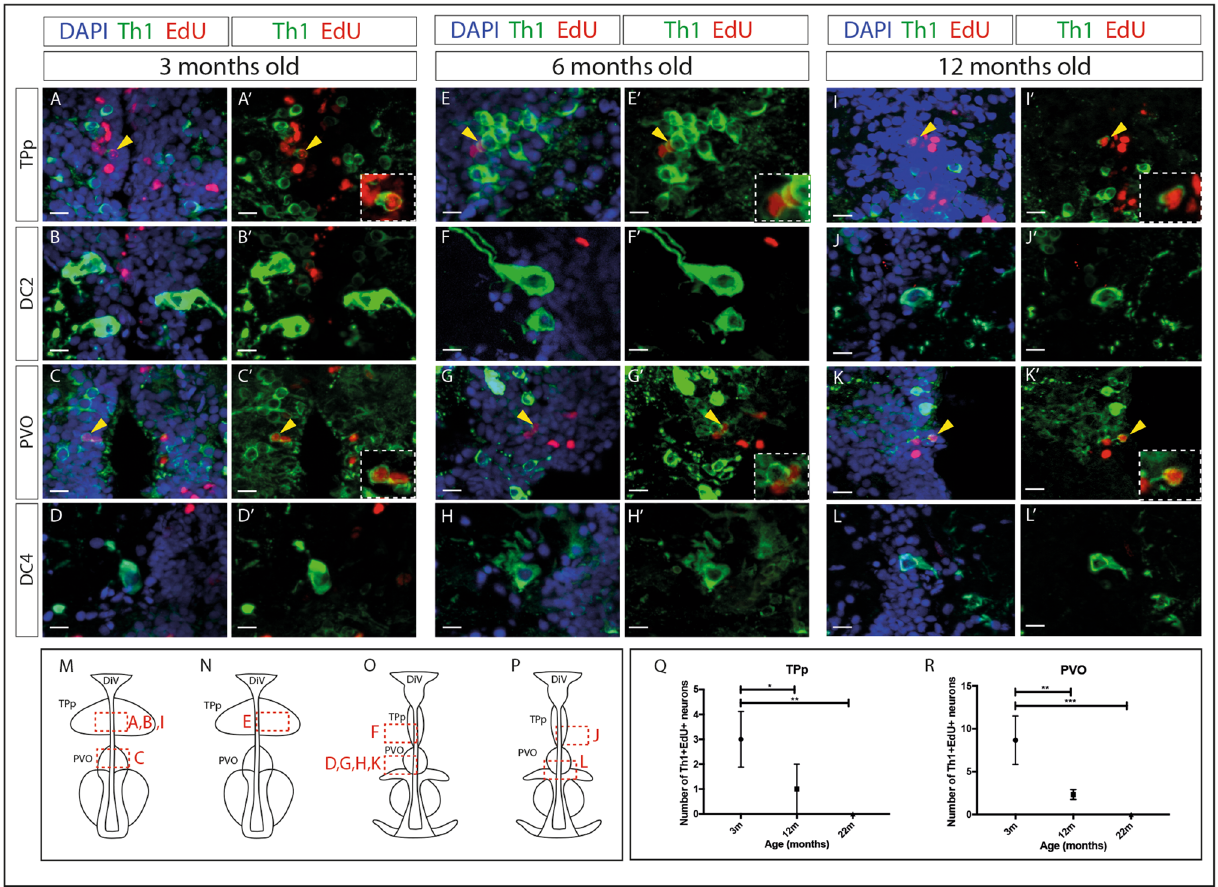
Figure 3. DA neurons are generated in the PT in adulthood, but generation decreases with age. ( A–L ′ ) Immunohistochemical analysis for Th1 (green), ClickIT™ labeling for EdU (red) and counterstained with DAPI (blue) ( A , B , C , D , E , F , G , H , I , J , K , L ) or shown without DAPI ( A ′ , B ′ , C ′ , D ′ , E ′ , F ′ , G ′ , H ′ , I ′ , J ′ , K ′ , L ′ ) in representative transverse sections of 3 month ( A – D ′ )(n = 9 fish), 6 month ( E – H ′ )(n = 2 fish) or 12 month ( I – L ′ )(n = 3 fish) wild type zebrafish brains. Th1 + EdU + cells are detected in the TPp in 3 month ( A , A ′ ), 6 month ( E , E ′ ) and 12 month ( I , I ′ ) old brains, and in the PVO of 3 month ( C , C ′ ), 6 month ( G , G ′ ) and 12 month ( K , K ′ ) old brains. No EdU labelling was detected in DC2 neurons ( B , B ′ , F , F ′ , J , J ′ ) or DC4 neurons ( D , D ′ , H , H ′ , L , L ′ ). Yellow arrowheads point to double-positive cells and insets show magnified image of double-labeled cells. Yellow dashed line indicates ventricle. Scale bars: 10 μm. ( M–P ) Schematics indicating the position of images ( A – L ′ ) within the PT, red boxes indicate position of the corresponding image in relation to the ventricle. Images in ( A – L ′ ) are representative of sections across the entire A–P extent of each population; those chosen best highlight the distinct morphology of each neuronal population. ( Q ) Quantitative analyses through the entire population shows that the number of Th1 + EdU + cells in the TPp is decreased in 12 month fish (n = 3 fish) compared to 3 month fish (n = 9 fish) (two-way ANOVA, p = 0.0277), and further decreased in 22 month fish (n = 3 fish) compared to 3 month fish (two-way ANOVA, p = 0.0019). ( R ) The number of Th1 + EdU + cells in the PVO is decreased in 12 month fish (n = 3 fish) compared to 3 month fish (n = 9 fish) (two-way ANOVA, p = 0.0039), and further decreased in 22 month fish (n = 3 fish) compared to 3 month fish (two-way ANOVA, p = 0.0003). Schematic in ( M – P ) is based on anatomical drawings by Rink and Wullimann 25 than in pink1 +/+ zebrafish resulting in a lower number of DA neurons with a considerably greater difference at 24 months (Fig. 5H). The loss of PINK1 therefore leads to a reduction in neuronal populations in both DA subsets that expand in adulthood and those that do not. The reduction of the DC2 A population in later life stages suggests that DC2 A DA neurons may degenerate in zebrafish lacking functional PINK1. However, the reduction in expanding popula- tions could occur either as a consequence of degeneration or as a consequence of reduced de novo neurogenesis. We therefore directly addressed whether loss of Pink1 inhibits neurogenesis in adult-expanding populations by analysing the generation of DA neurons in 3 month pink1 +/+ and pink1 -/- zebrafish through acute EdU-labelling. The number of newly-generated Th1 + EdU + neurons is significantly decreased in both the TPp (Fig. 5A) and the PVO (Fig. 5B) in pink1 -/- zebrafish compared to pink1 +/+ siblings. To assess whether loss of PINK1 results in overall reduction in proliferation, the total number of EdU + cells was quantified in these areas, which also contain serotonergic neurons and glial cells rather than just DA neurons. There was no significant difference in